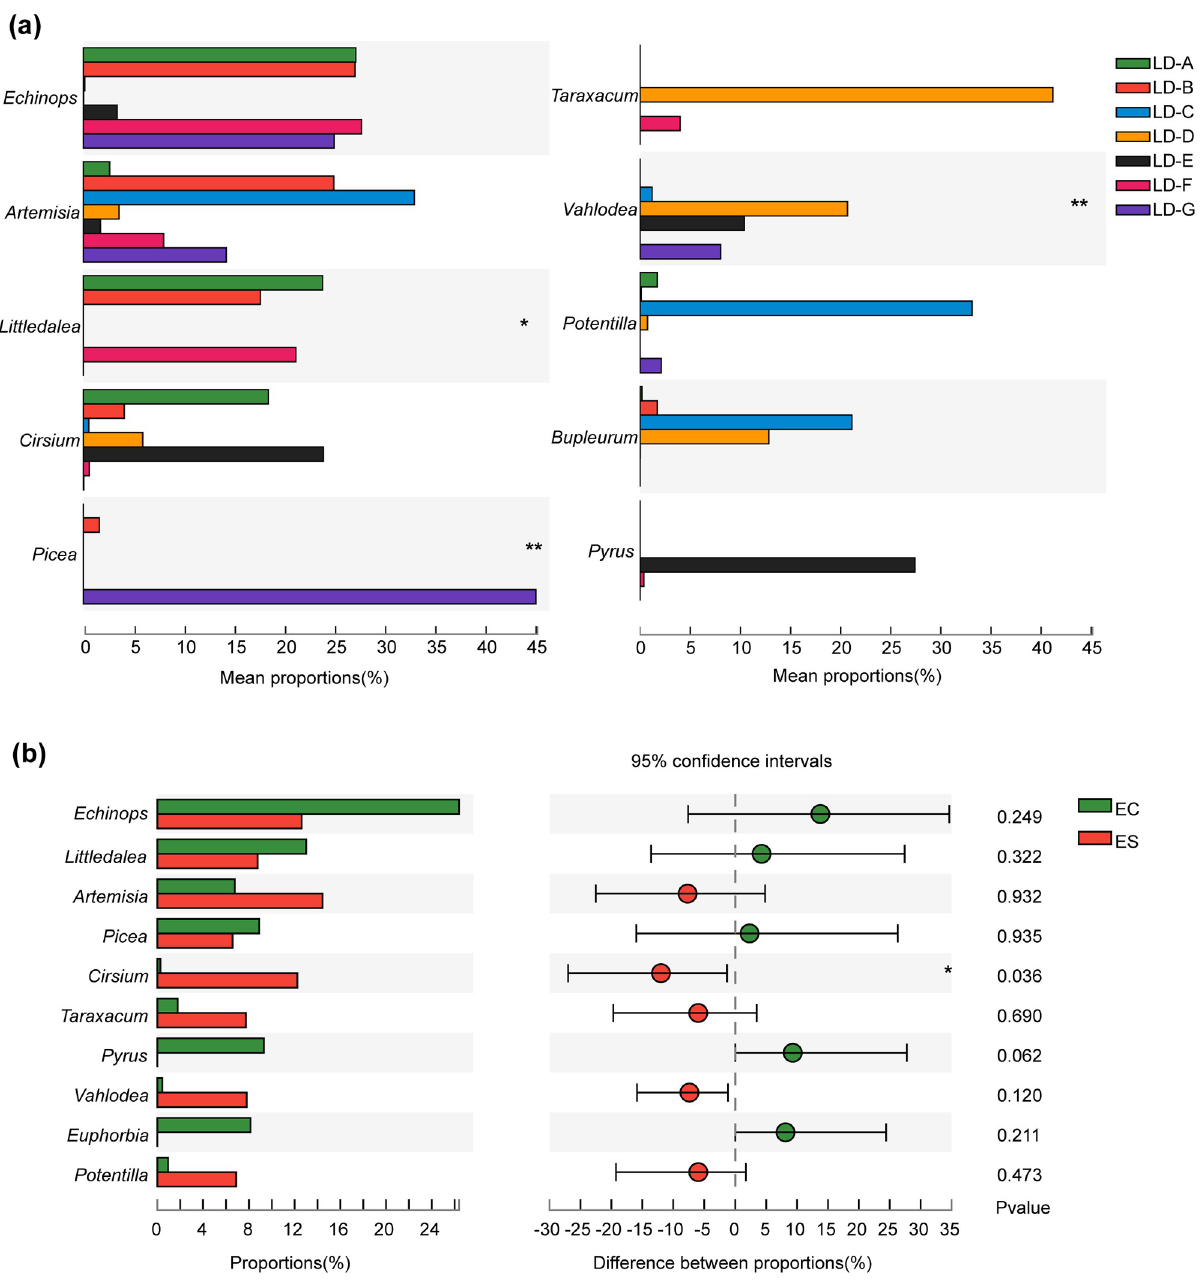
Fig 6. Analysis of the difference between zokor species and different study areas. a shows the top ten food species of the food composition %RA of zokor in seven study areas. b shows the top ten food species in %RA of interspecific food composition of two zokor species.